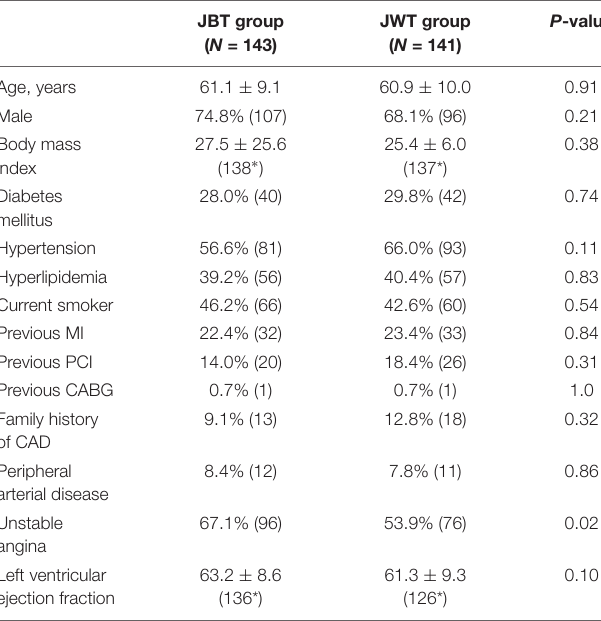
TABLE 1 | Baseline characteristics (intention-to-treat population).